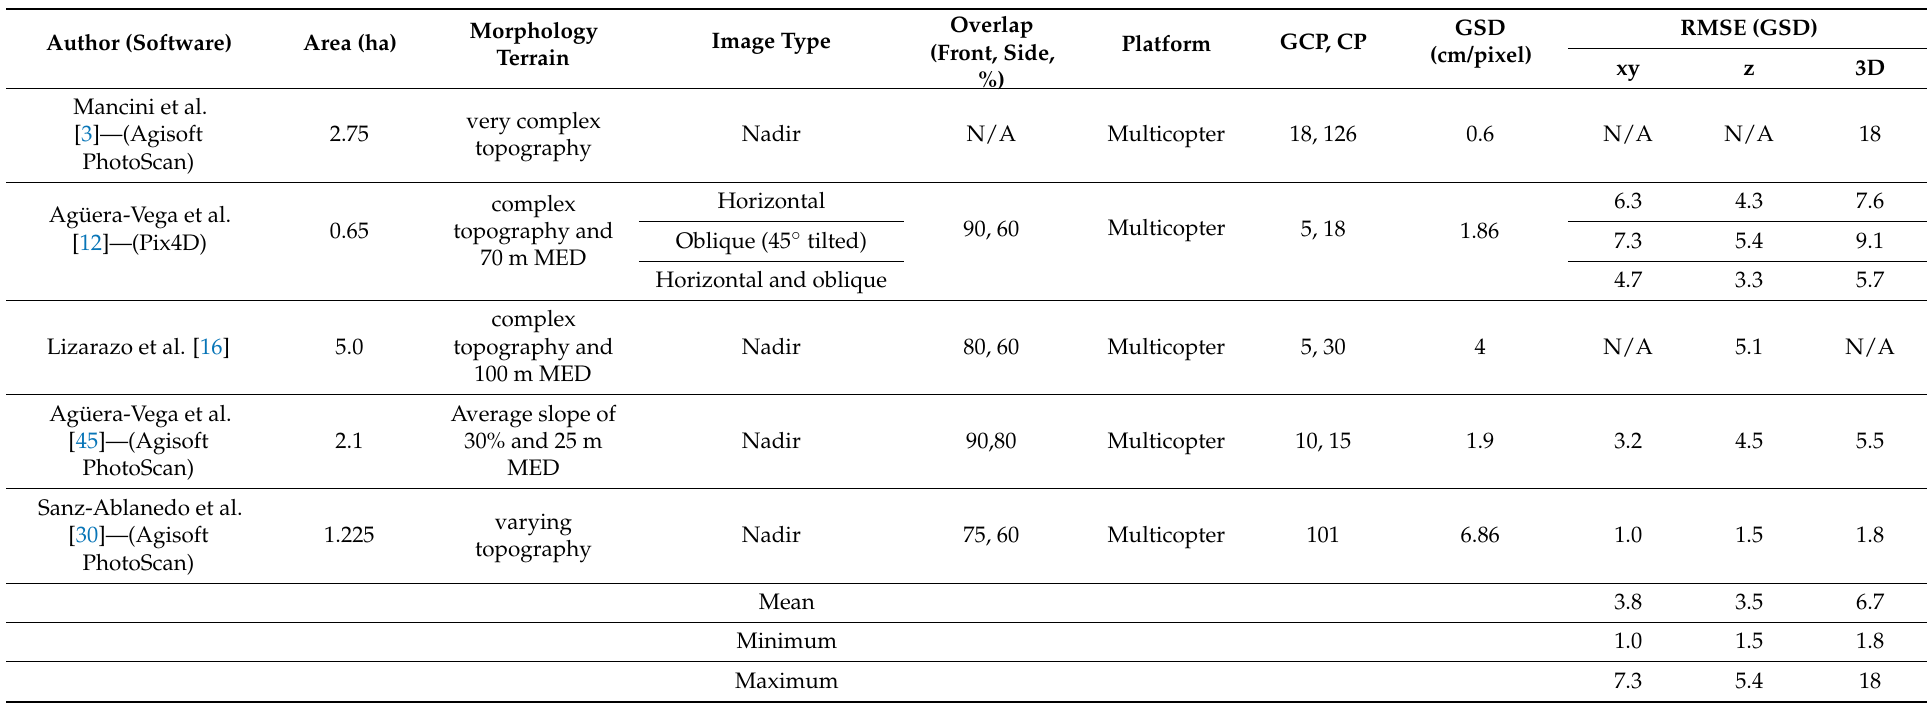
Table 7. The RMSE reported in different UAV photogrammetry studies for complex